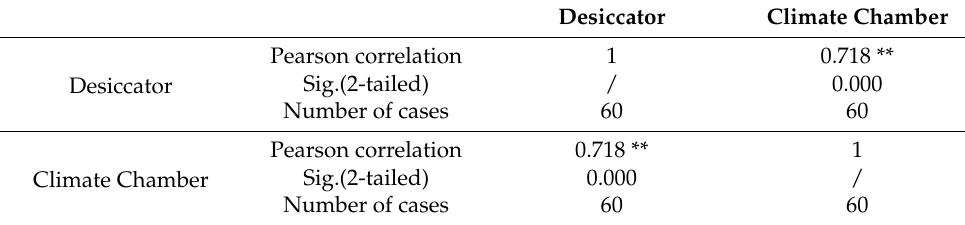
Table 4. Regression model of formaldehyde emissions between the desiccator and climate chamber. Unstandardized Standardized Coefficients Coefficients t Significance Model a B Standard Error Beta (Constant) 0.009 0.001 / 7.623 0.000 1 Desiccator 0.023 0.003 0.718 7.849 0.000